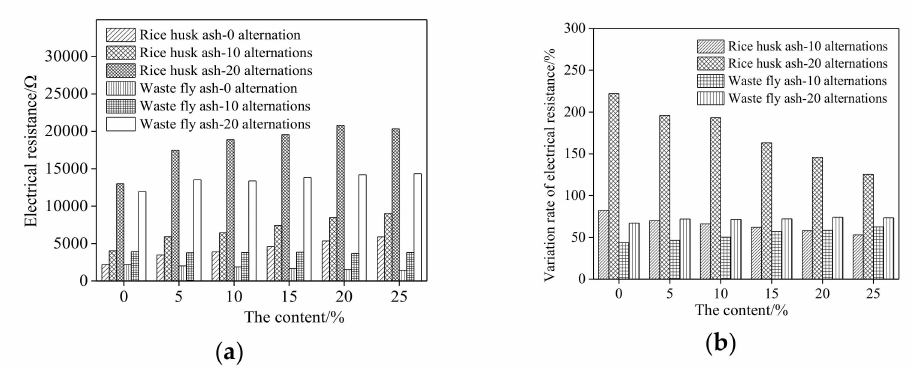
Figure 11. The electrical resistance of RPC during NaCl dry–wet alternations. ( a ) The electrical resistance. ( b ) The variation rate of electrical.